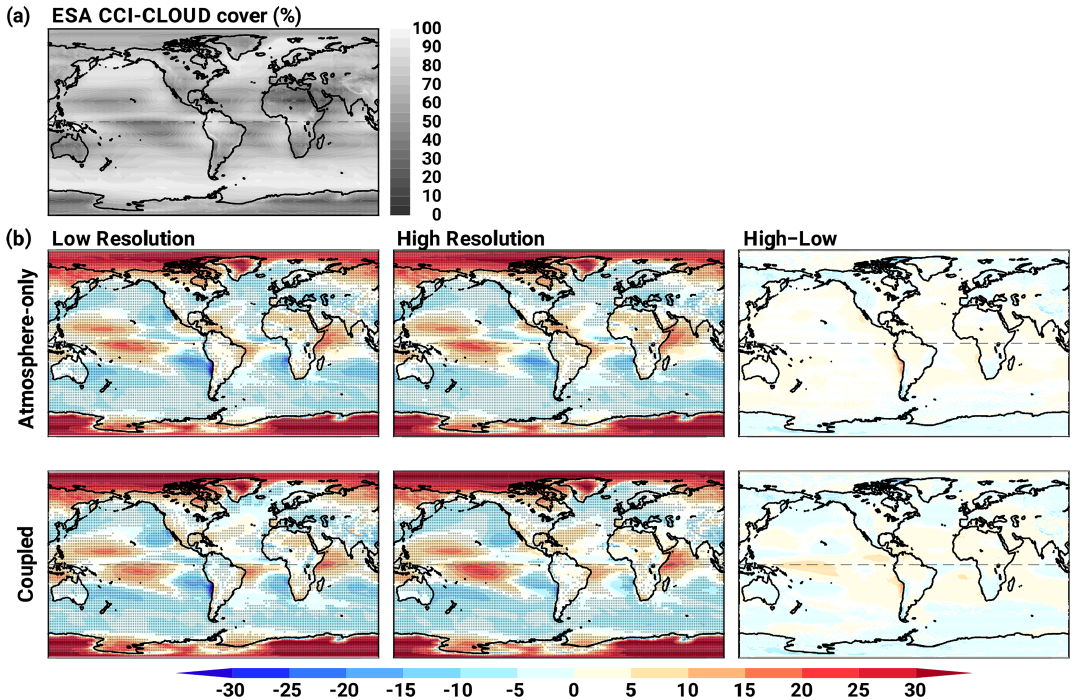
Figure 4. (a) ESA CCI-CLOUD cover (in %). (b) Multi-model ensemble mean bias in net cloud cover (in %) with respect to ESA CCI- CLOUD at low and high resolution (left and middle) and differences between the two resolutions (right), as in Fig. 1.